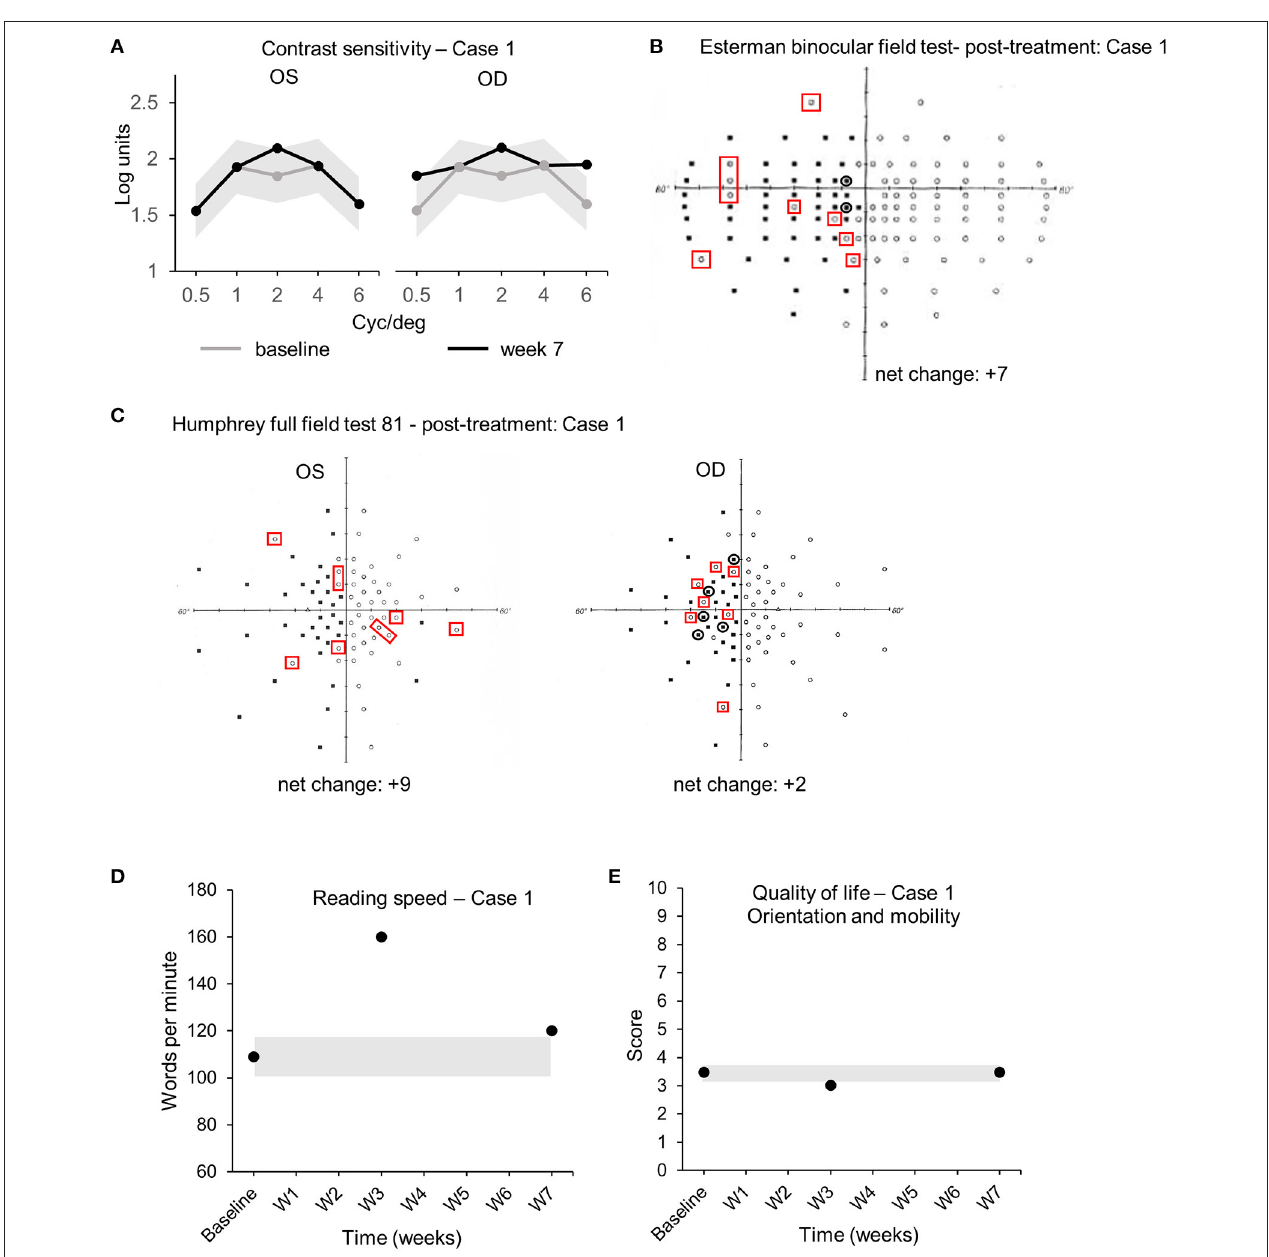
FIGURE 3 | Case 1—Visual outcome measures. (A) Contrast sensitivity at baseline (gray line) and at the end of the treatment (week 7—black line) in the left (OS) and the right (OD) eye. (B) Esterman binocular field test post-treatment (week 7). Red squares indicate newly acquired points, black circles indicate lost points, compared to baseline. (C) Monocular Humphrey full-field test (81 points) post-treatment (week 7) in the left (OS) and right (OD) eye. Red squares indicate newly acquired points, and black circles indicate lost points, compared to baseline. (D) Reading speed at baseline, week 3, and post-treatment (week 7). (E) Quality of life scores at baseline, week 3, and post-treatment (week 7). Gray shaded areas in (A,D,E) indicate the values of the coefficient of repeatability ( ± COR). OD, oculus dexter ; OS, oculus sinister ; W, week. mobility section of the quality of life questionnaire showed only minor improvement [ + 0.62 logits, COR ± 0.44 logits (22), Table 3 , Figure 4E —black triangles]. No improvements in visual acuity, RS, and FS were observed between all time points ( Table 3 ). No adverse events were reported for the duration the home-based stimulation program [VRISE questionnaire score = 33/35, > 25 the threshold for cybersickness (